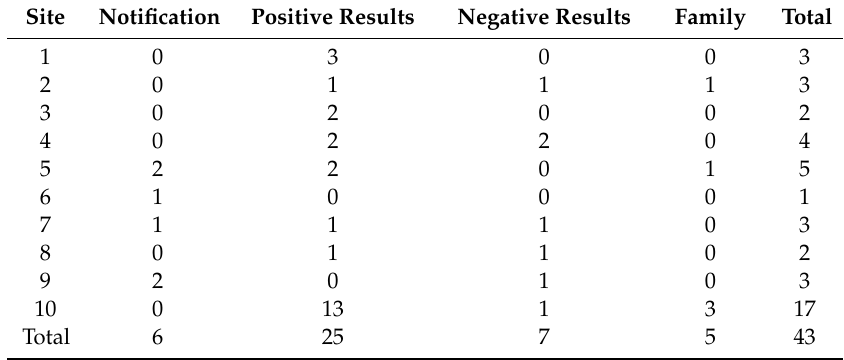
Table 1. Letter Types.